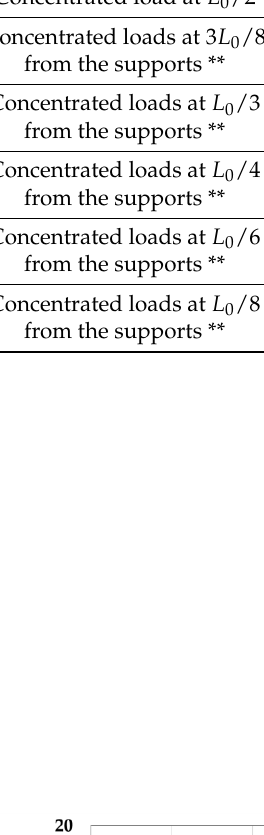
( b ) Figure 5. Verification of results from the present study with those of Mohri et al. [20] and from computer programs LTBeamN and PRFELB for Case 2 of the in-plane loading system: ( a ) beam-column of section IPE 180; ( b ) beam-column of section HEB 180. The solution of the present study is valid for the in-plane loading systems that are not necessarily symmetric, in reference to the member mid-length cross-section. Since the greatest difference between the LEA equivalent uniform moment-modification-factors and those from NEA of the present study are identified for asymmetric-loading systems, the antisymmetric in-plane loading systems are of concern for the verification. The same member length as well as the loading and section types are concerned. A shear-center uniformly distributed load over the half length of the member (Case 3: i = 1 but 𝜓 𝑞,𝑖 = −1 ) and a concentrated load applied at the shear center one quarter of the beam-length from both supports (Case 4: j = 1 but 𝜓 𝑄,𝑗 = −1 ) are dealt with. The results are presented in Figures 6 and 7, respectively.